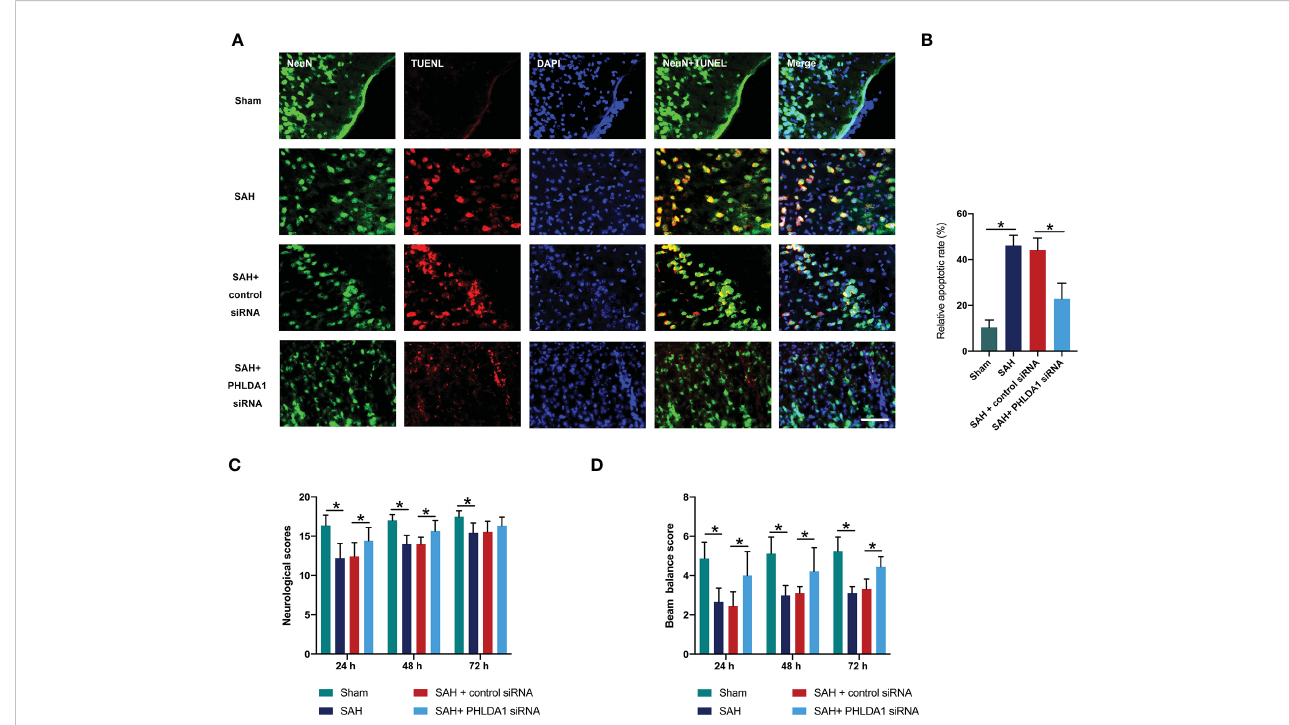
FIGURE 5 PHLDA1 de fi ciency decreased neuronal apoptosis and improved neurological function after SAH. (A) Representative immuno fl uorescence images of TUNEL staining in temporal cortex. (B) Quanti fi cation of TUNEL +/ NeuN + cells in temporal cortex (n = 6 per group). PHLDA1 de fi ciency mitigated neurological de fi cits (C) and improved motor function (D) after SAH (n = 8 or 9 per group). * P < 0.05. Scale bar=50 m m. Data are expressed as mean ±